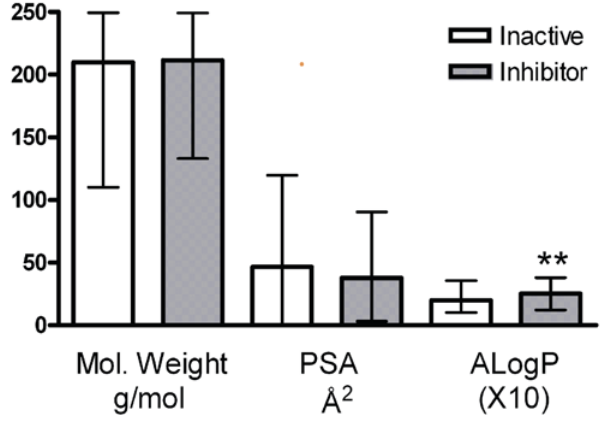
Figure 8. Filter performance. Applying screening criteria to both the inhibitor and inactive groups recovered 21/206 and 157/910 com- pounds respectively. In each of these filtered groups, the mean and range for molecular weight, polar surface area (PSA) and octanol/water partition coefficient (ALogP) are shown. While the inhibitor compounds are significantly more hydrophobic, as suggested by the higher mean ALogP (**, P , 0.005), the overlap is large and illustrates that the filters alone provide insufficient